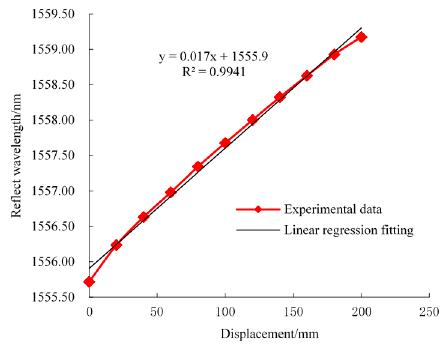
Figure 10. Reflected wavelength and displacement response curve (FBG roof separation sensor).